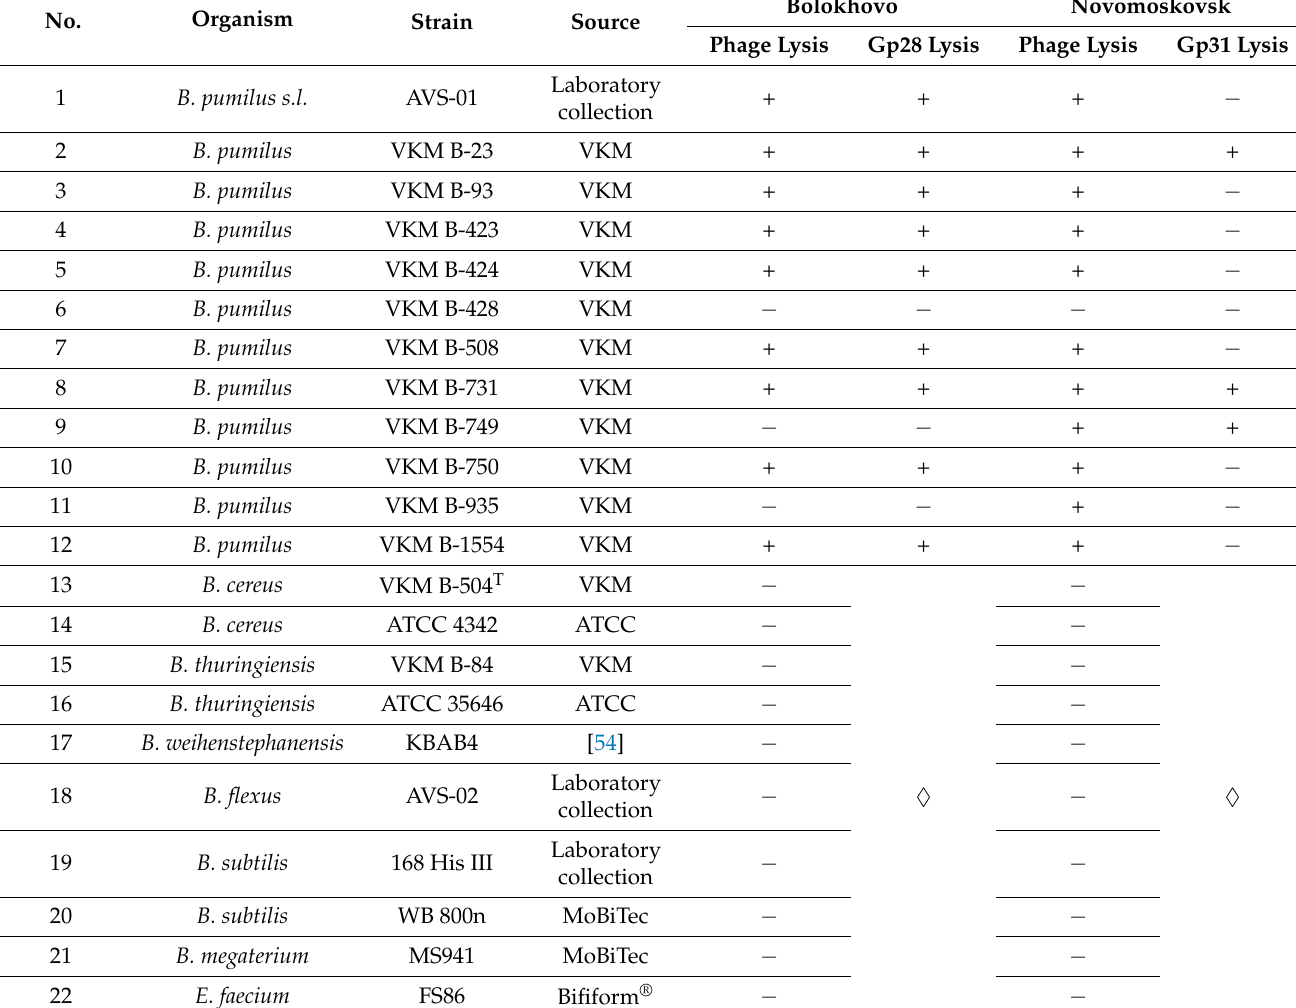
Table 1. The host range of the Bolokhovo and Novomoskovsk bacteriophages and the strain specificity of Gp28 и